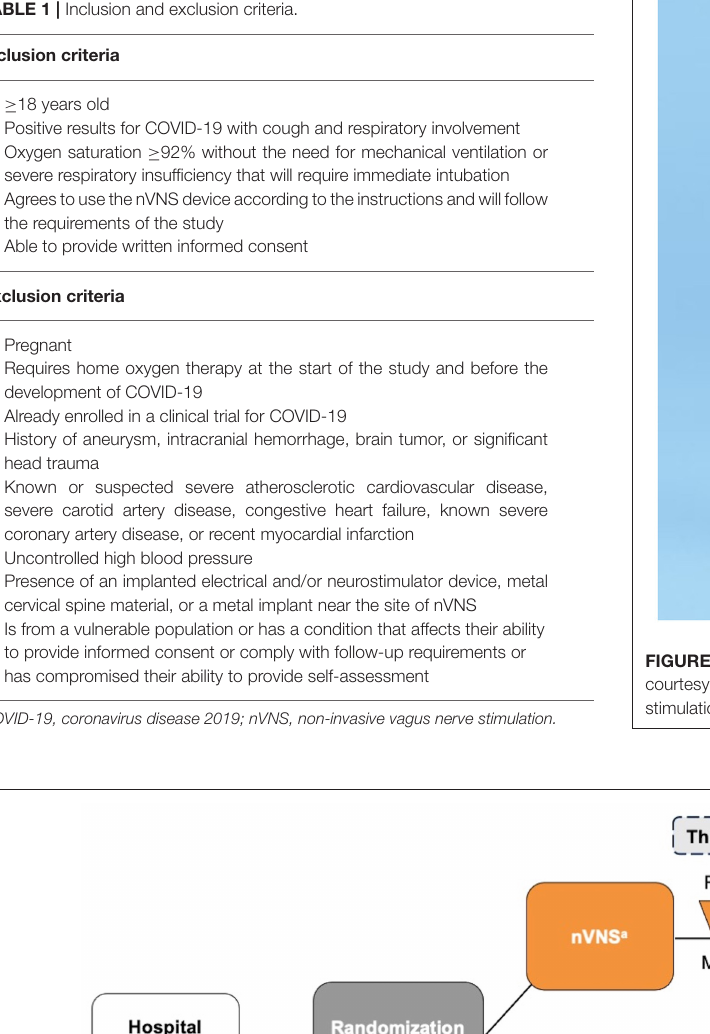
Frontiers in Neurology |